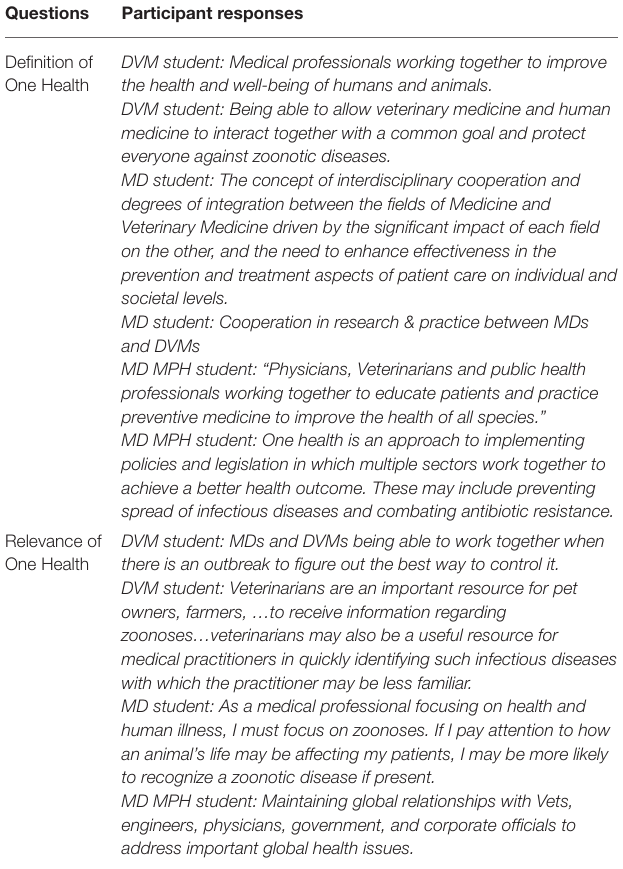
TABLE 3 | Interprofessional Collaboration and zoonoses